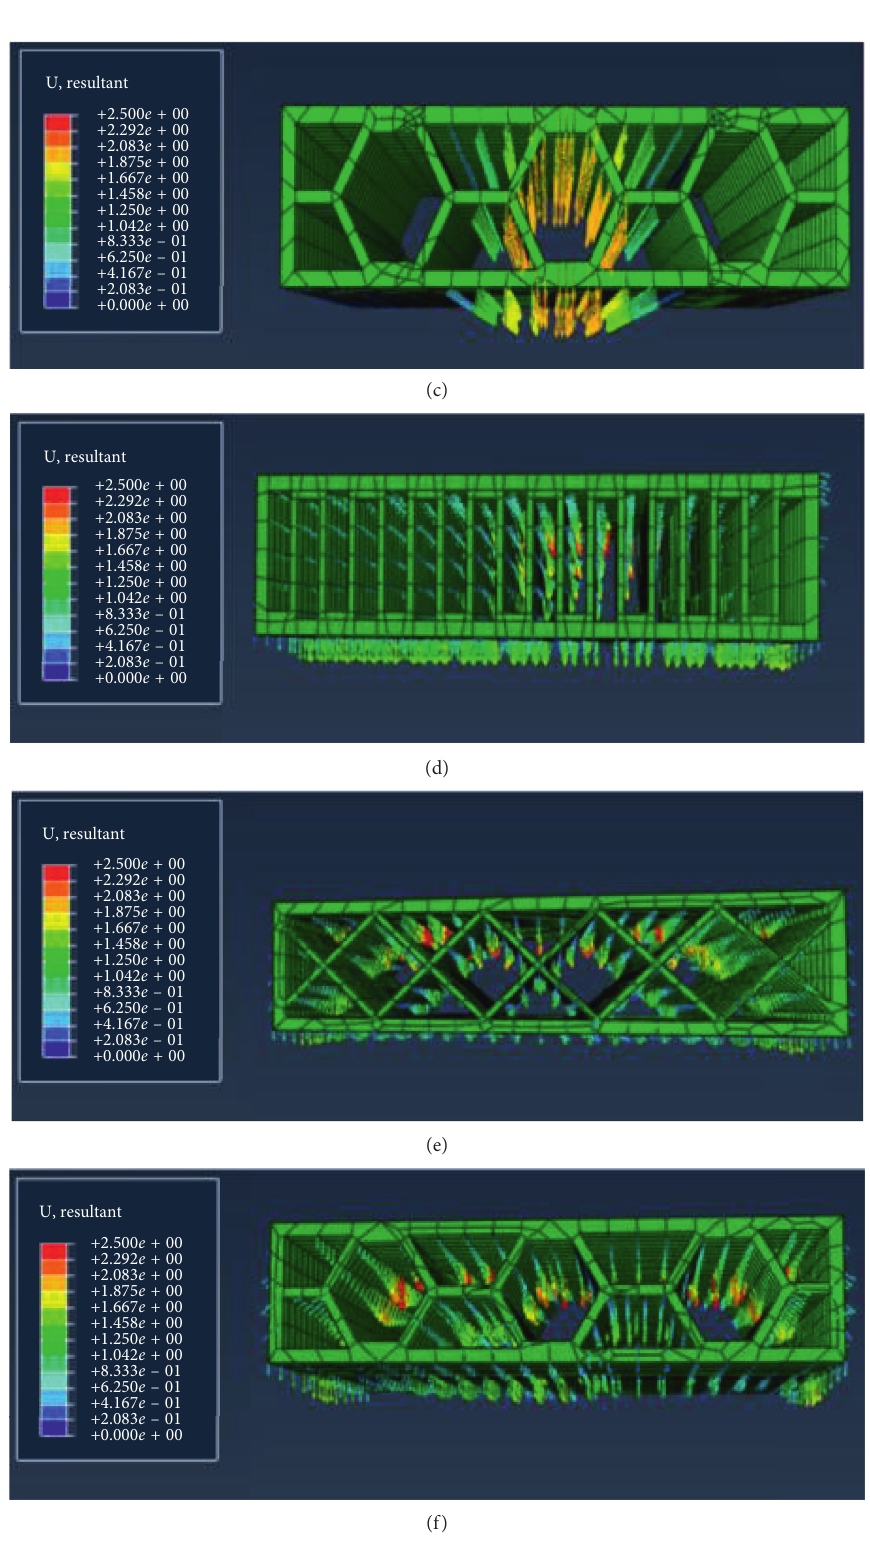
Figure 9: The tensile/compressive trend of three kinds of samples: (a) vertical supporting structure in perpendicular direction, (b) oblique square grid supporting structure in perpendicular direction, (c) honeycomb grid supporting structure in perpendicular direction, (d) vertical supporting structure in parallel direction, (e) oblique square grid supporting structure in parallel direction, and (f) honeycomb grid supporting structure in parallel